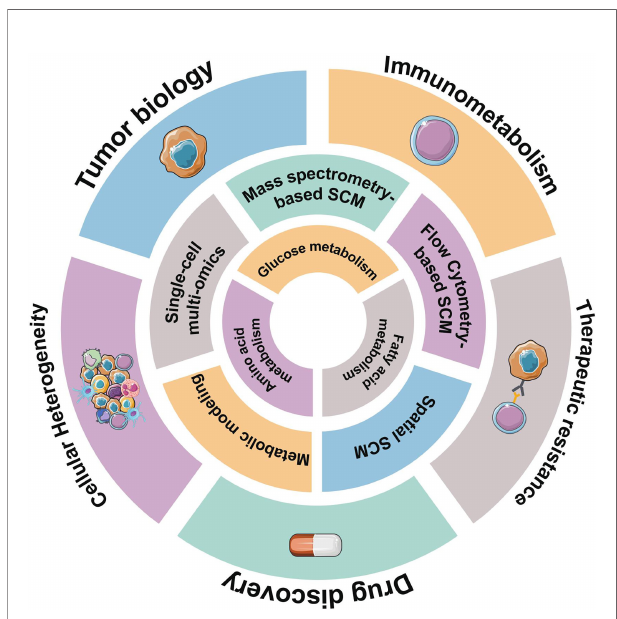
FIGURE 1 | Overview of representative single-cell metabolomics methods for metabolic pro fi ling. Hematological malignancies have abnormal metabolic characteristics, re fl ected in glucose metabolism, amino acids metabolism, and lipid-related metabolism. Some emerging single-cell metabolomics (SCM) techniques can help us better understand metabolic signatures at the single- cell level and provide unprecedented insights into hematological